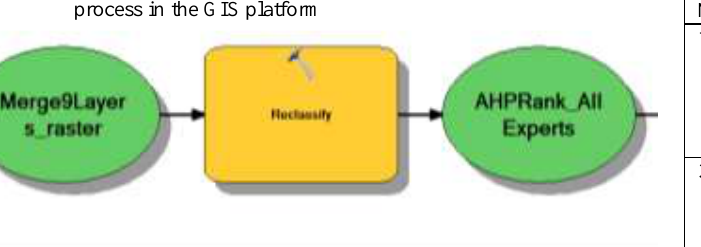
Figure 3: Reclassification of rasterized layers